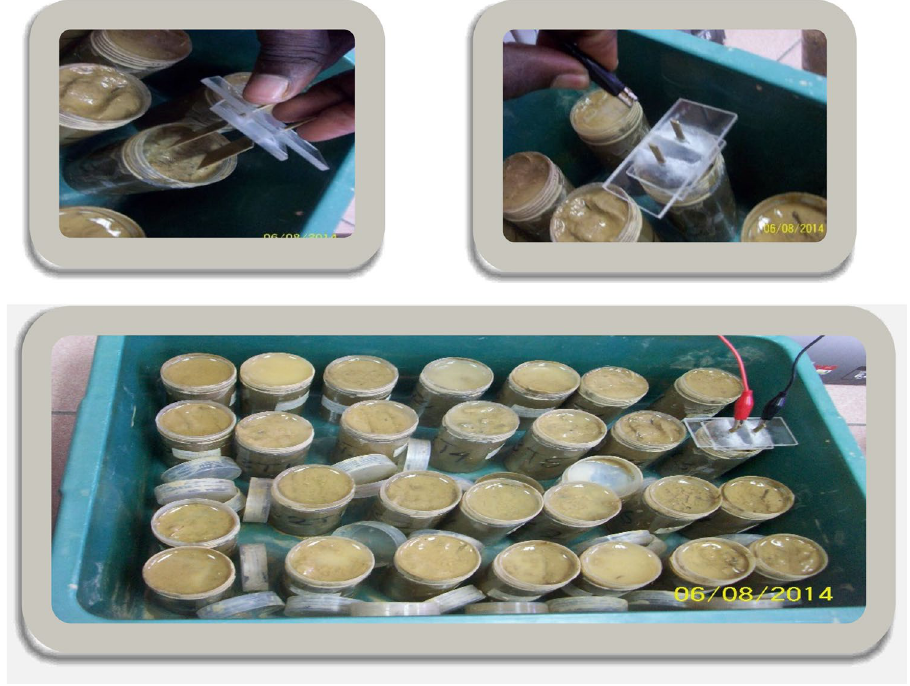
Figure 3. Parallel plate capacitor being inserted into the soil samples in a plastic